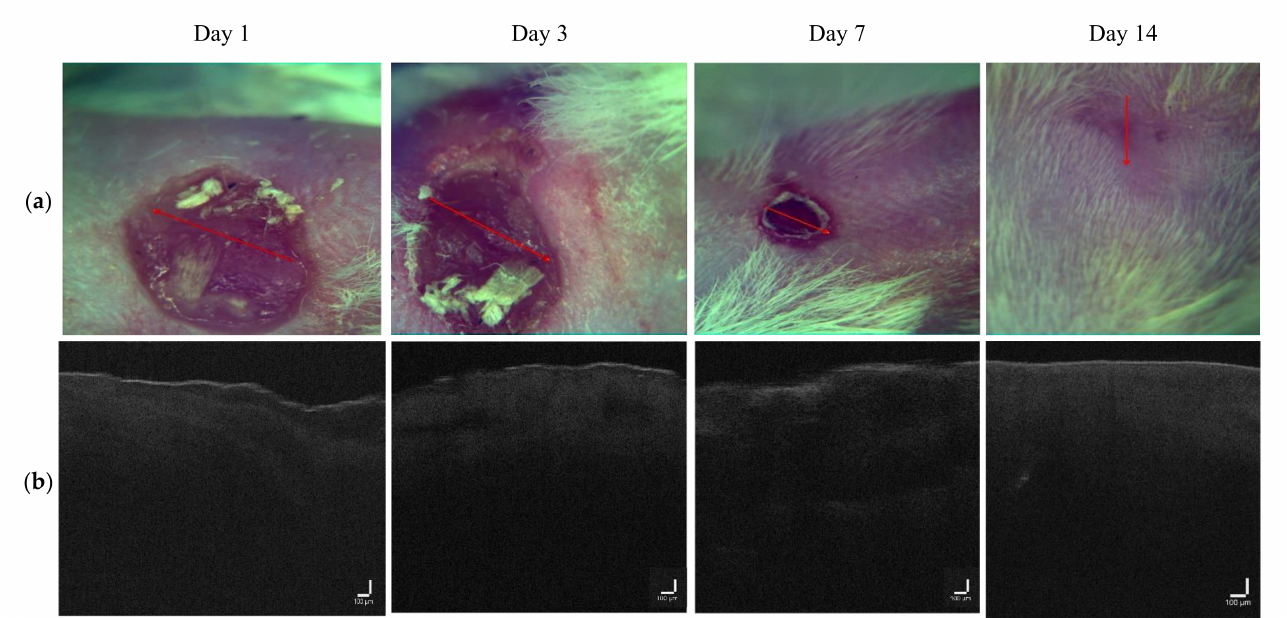
Figure 9. Dependence of signal intensity on depth for the ( a ) LDPDT-5-ALA 1 J/cm 2 group and ( b ) LDPDT-5-ALA 4 J/cm 2 group.